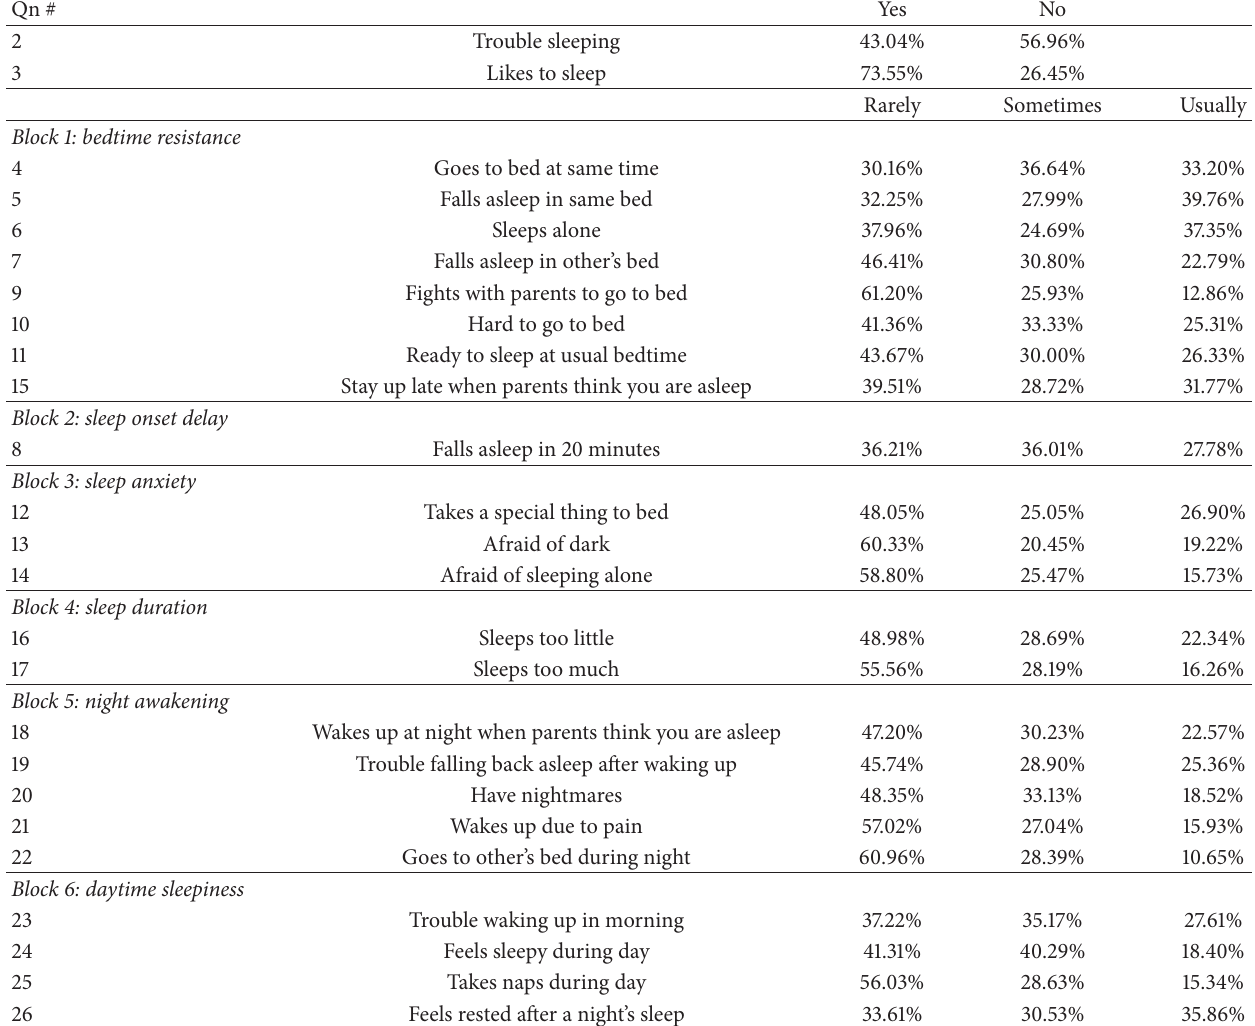
Table 2: Responses to the Children’s Sleep Habits Questionnaire from elementary school